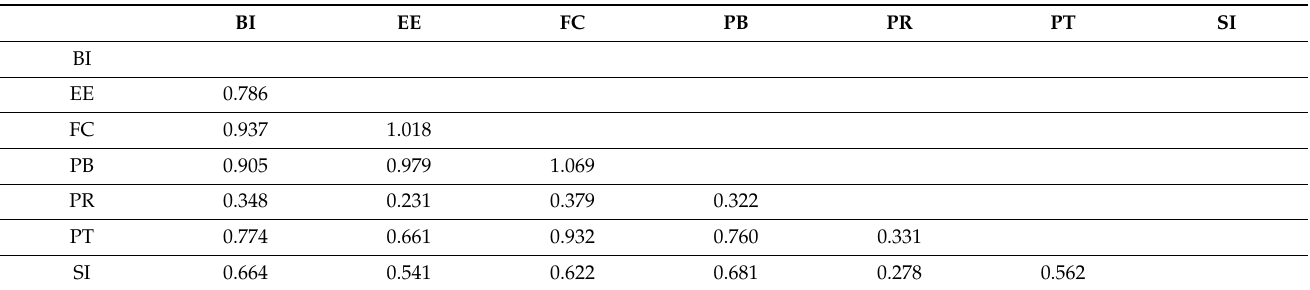
Table 5. Discriminant validity and heterotrait–monotrait (HTMT) values.